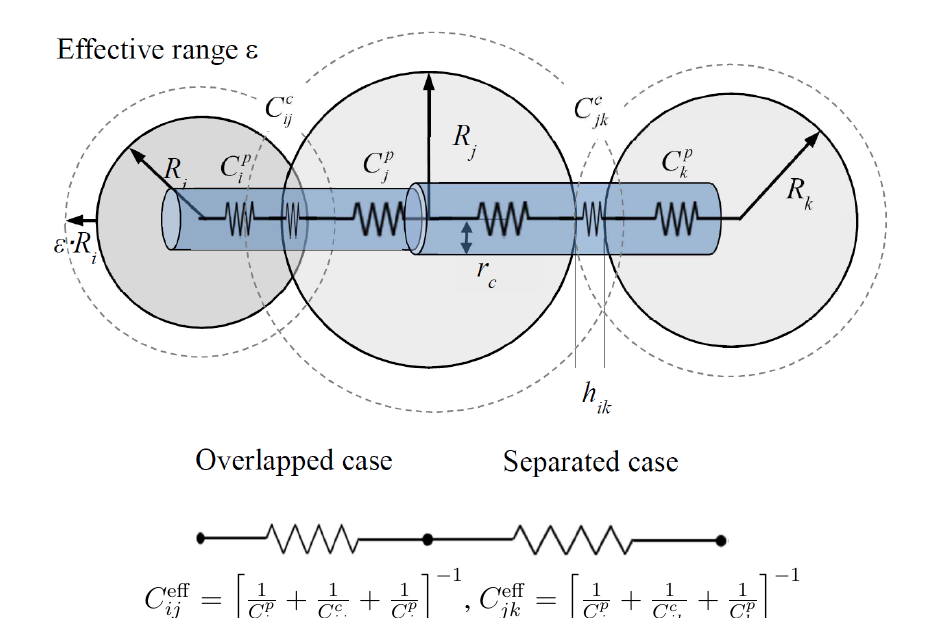
Figure 3. Illustration of generalization of thermal conductance between particles in the 3D random network model. The particle iis overlapped with particle j. Though particle k is separated from particle j, their distance is closer than the effective zone, which is determined by cutoff range parameter ε